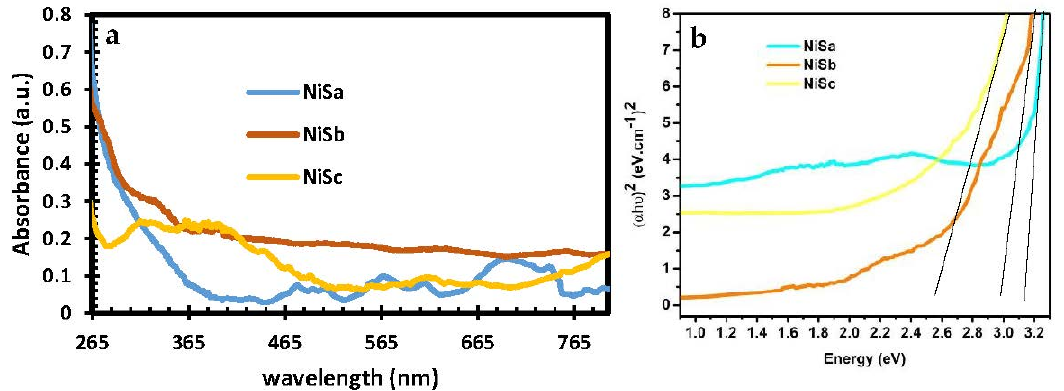
Figure 3. UV—Vis ( a ) and Tauc plot ( b ) spectra for NiSa, NiSb, and NiSc nanoparticles.